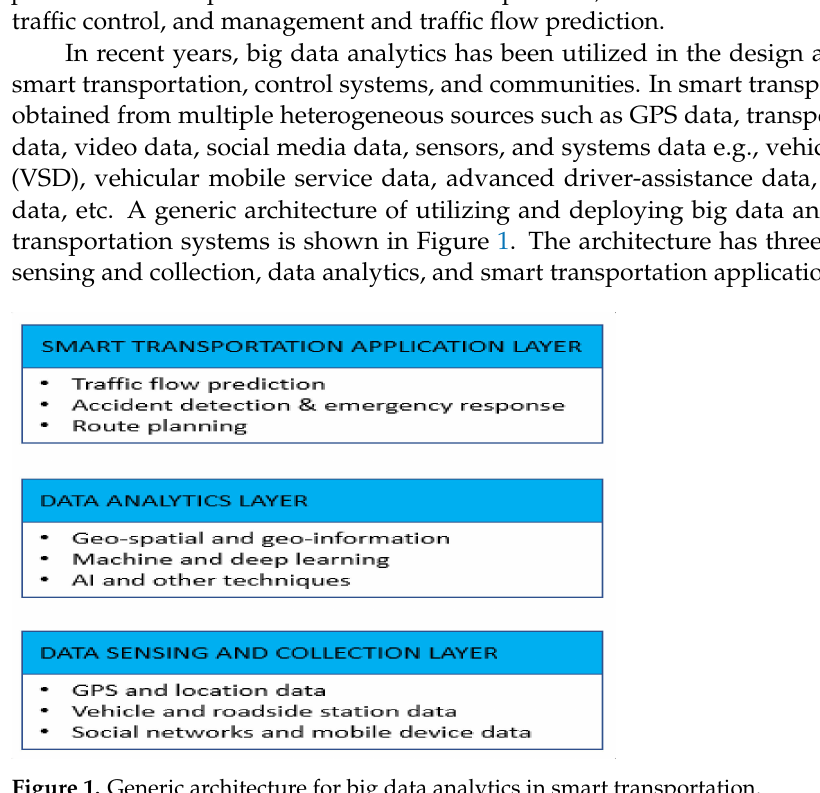
Figure 1. Generic architecture for big data analytics in smart